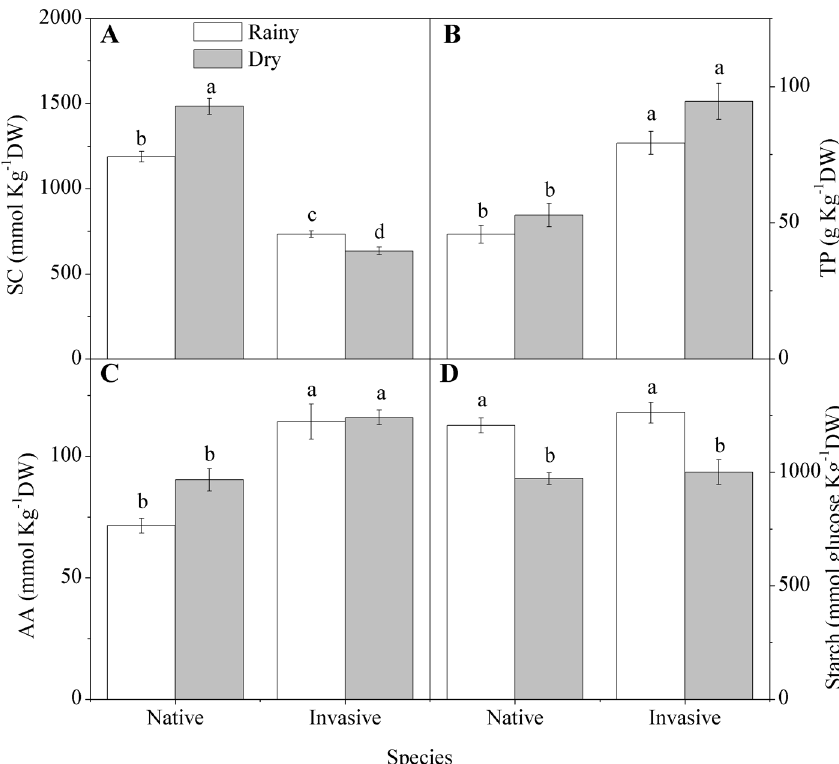
Figure 4. Leaf biochemistry in native ( Anadenantheracolubrina) and invasive ( Prosopisjuliflora ) species in a tropical dry forest in Brazil across seasons: (A) soluble carbohydrates (SC); (B) total proteins (TP), (C) amino acids (AA); (D) starch. Values represent the average of replicates (n=20 6 SE; invasive dry season n=25 6 SE). Different letters denote statistical differences by Newman-Keul test with significance level of 5 percent between variables.